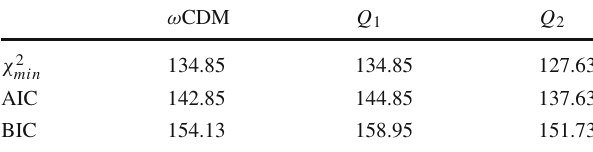
Table 2 Comparison among the models under study. The non interact- ing ω CDM, and the interacting models, (i) Q 1 = 3 H γρ m and model (ii) Q 2 = 3 H γρ x . We display the χ 2 value for the best fit using all min the observational probes, together the value for the AIC and BIC as is discussed in the